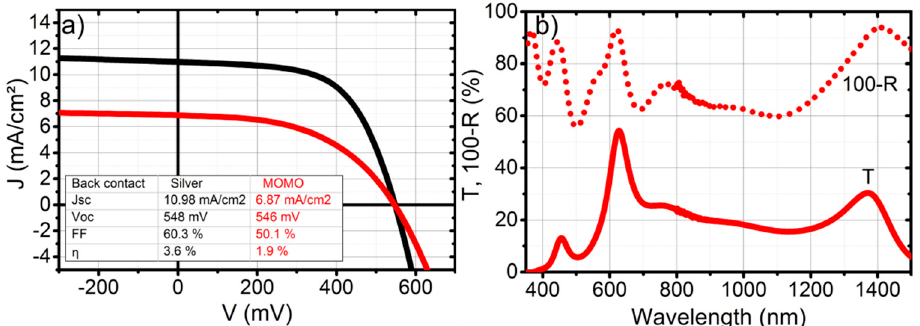
Figure 10. Comparison of IV -curves ( a ) for an opaque (black) and a spectrally selective solar cell (red) with a-Ge:H thickness ~5 nm. A corresponding transmission and reflection spectrum of the spectrally selective solar cell ( b ).